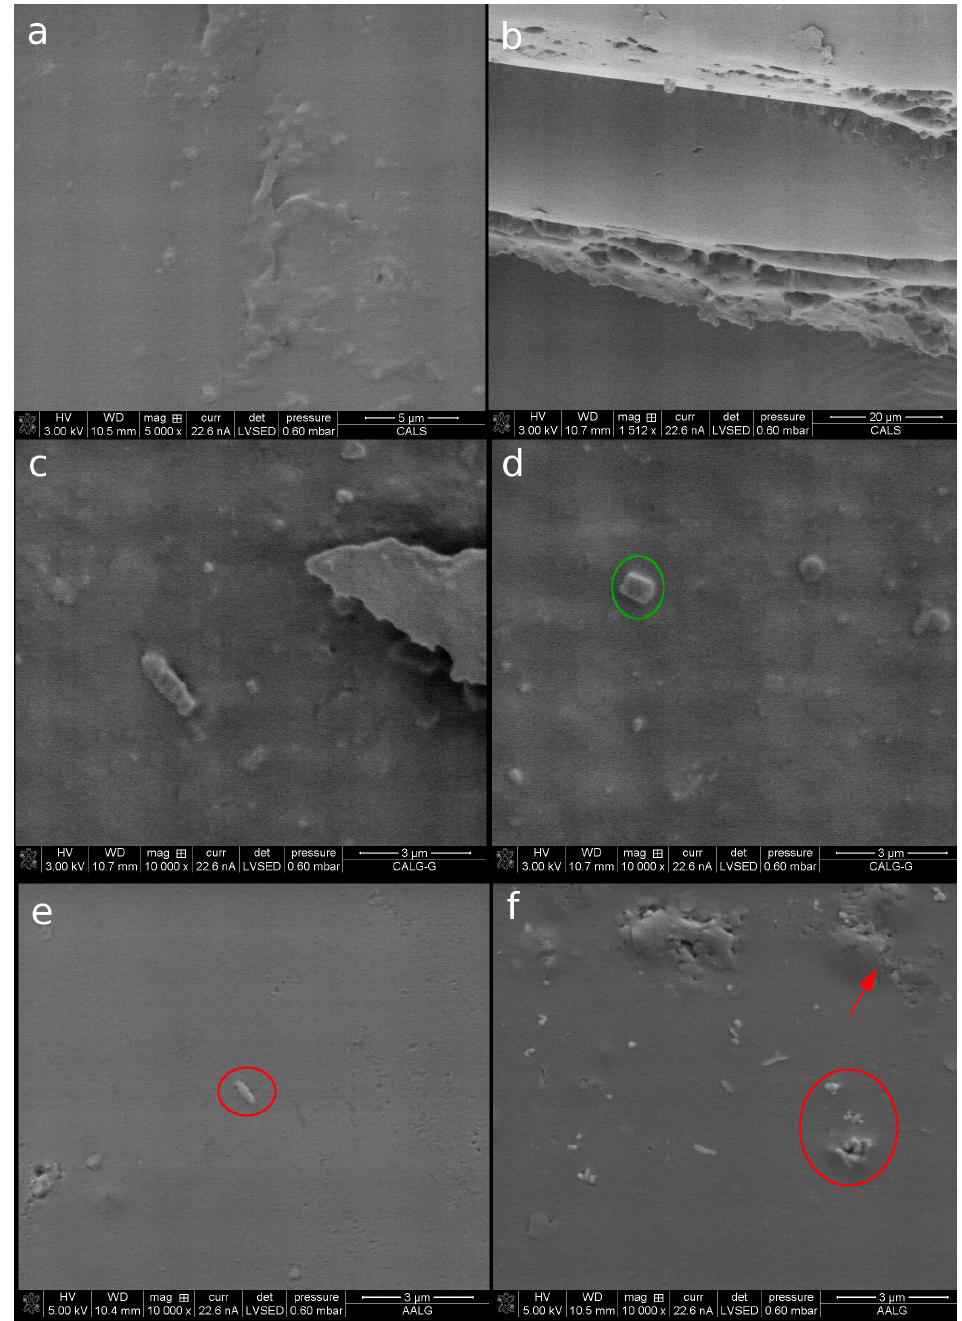
Figure 6. Scanning electron microscopy of B. bacteriovorus HD100 in: ( a ) CA-S film at 5000 × , and ( b ) 1512 × ; ( c , d ) CA-G film at 10,000 × ; ( e , f ) StA-G film at 10,000 × . The red circles enclose B. bacteriovorus , the arrow points to some specimens embedded in the polymeric matrices, and the green circle encloses a prominence attributed to collagen